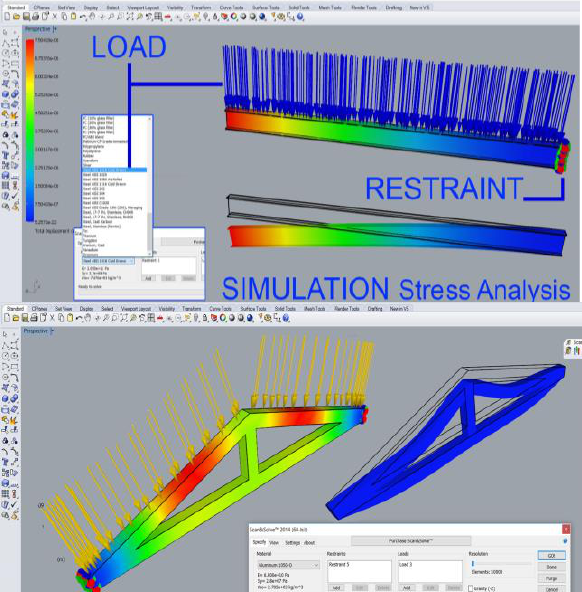
Fig. 6 NURBS Interpolation for BIM to MA/FEA.